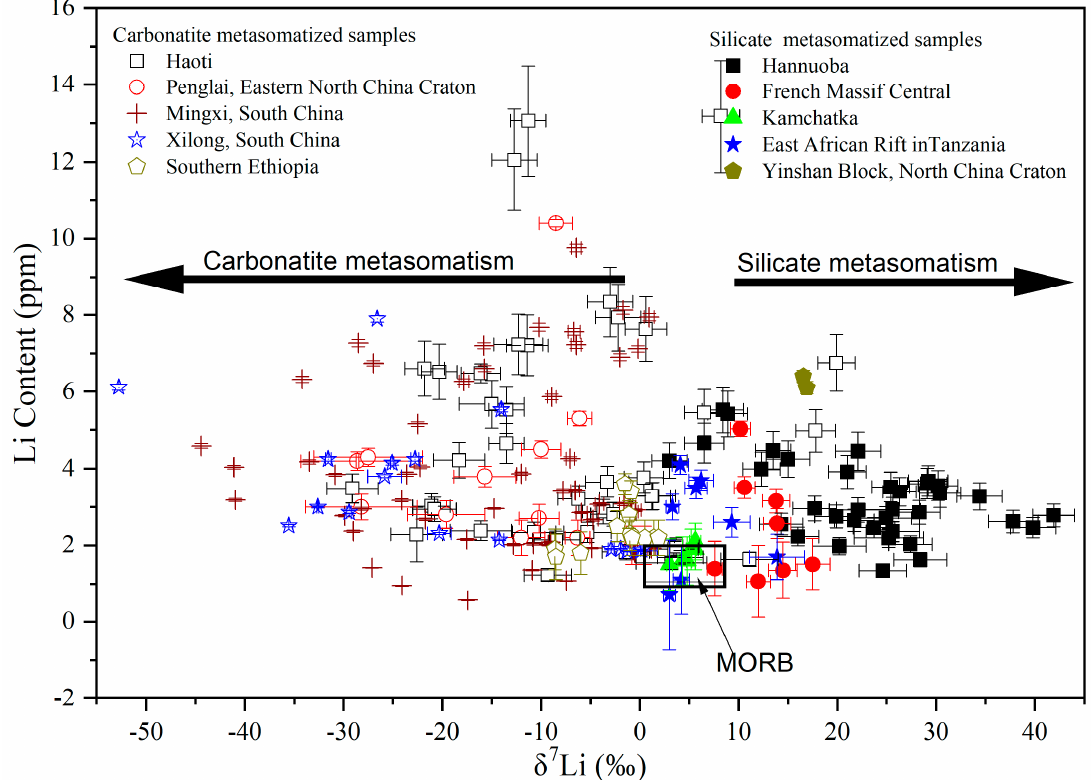
Figure 1. Olivine δ 7 Li vs. Li plot for discriminating the mantle metasomatic agents. Data source: Hannuoba and Haoti [7]; French Massif Central [12]; Kamchatka [13]; East African Rift (Tanzania) [14]; Yinshan Block (North China Craton) [15]; Mingxi and Xilong (Yangtze Craton) [16]; Penglai (North China Craton) [17]; Southern Ethiopia [18]; Lower crust xenoliths [19]; Upper continental crust [20]; Mid ocean ridge basalt (MORB) [21,22].